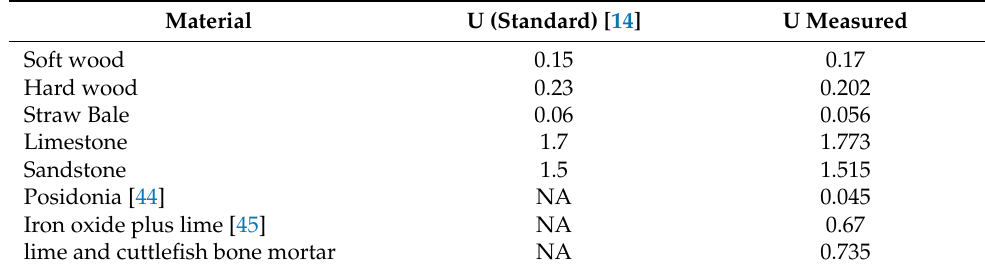
Table 3. Some examples of measured materials.